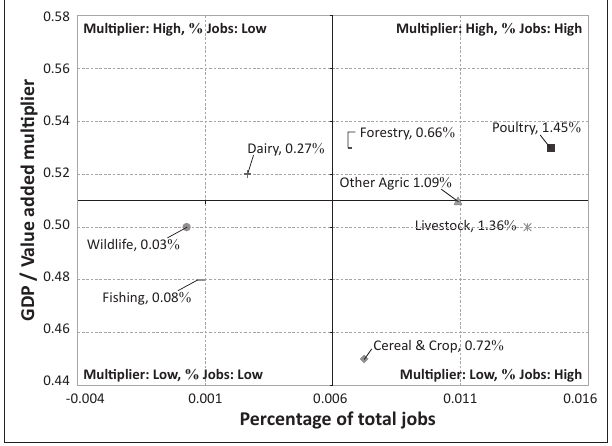
Direct Multipliers Indirect